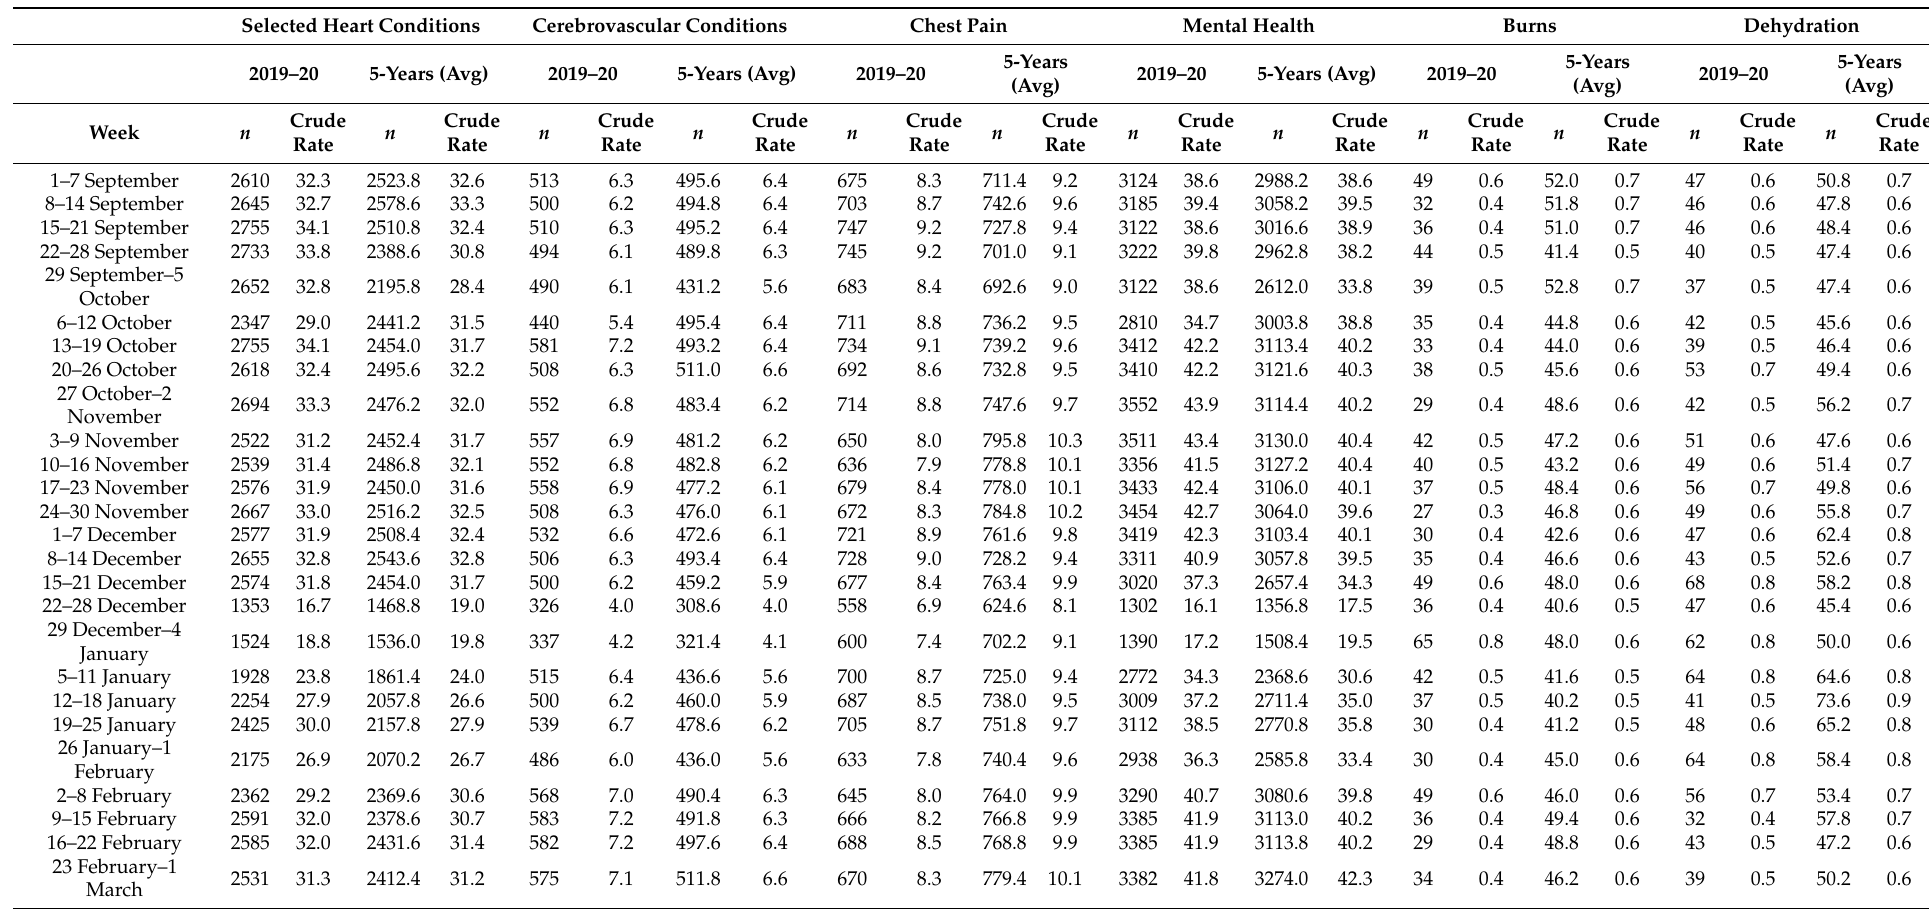
Table 4. Number and crude rate of admitted patient hospitalisations during the 2019–2020 bushfire season and previous 5-years